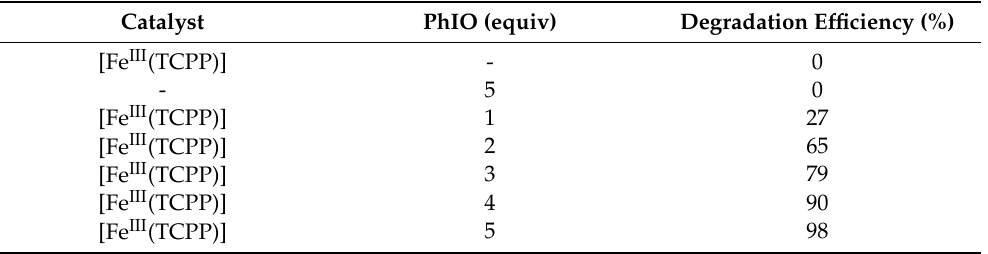
Table 1. [Fe III (TCPP)]-catalyzed degradation 1 of gentian violet by PhIO.